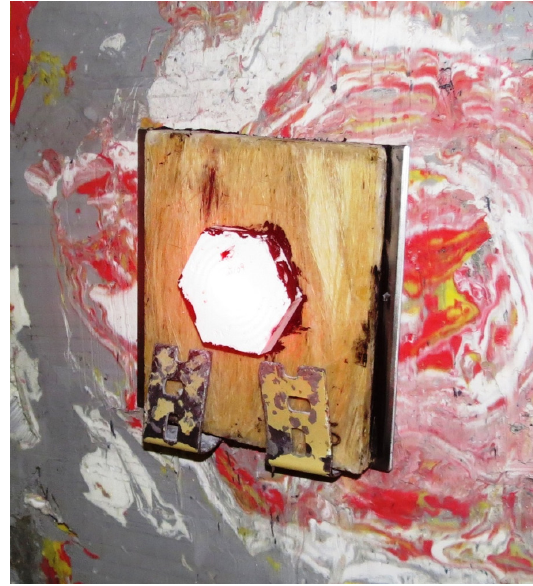
Figure 2. Complete multilayered armor clamped into the clay witness and ready to be ballistic tested.